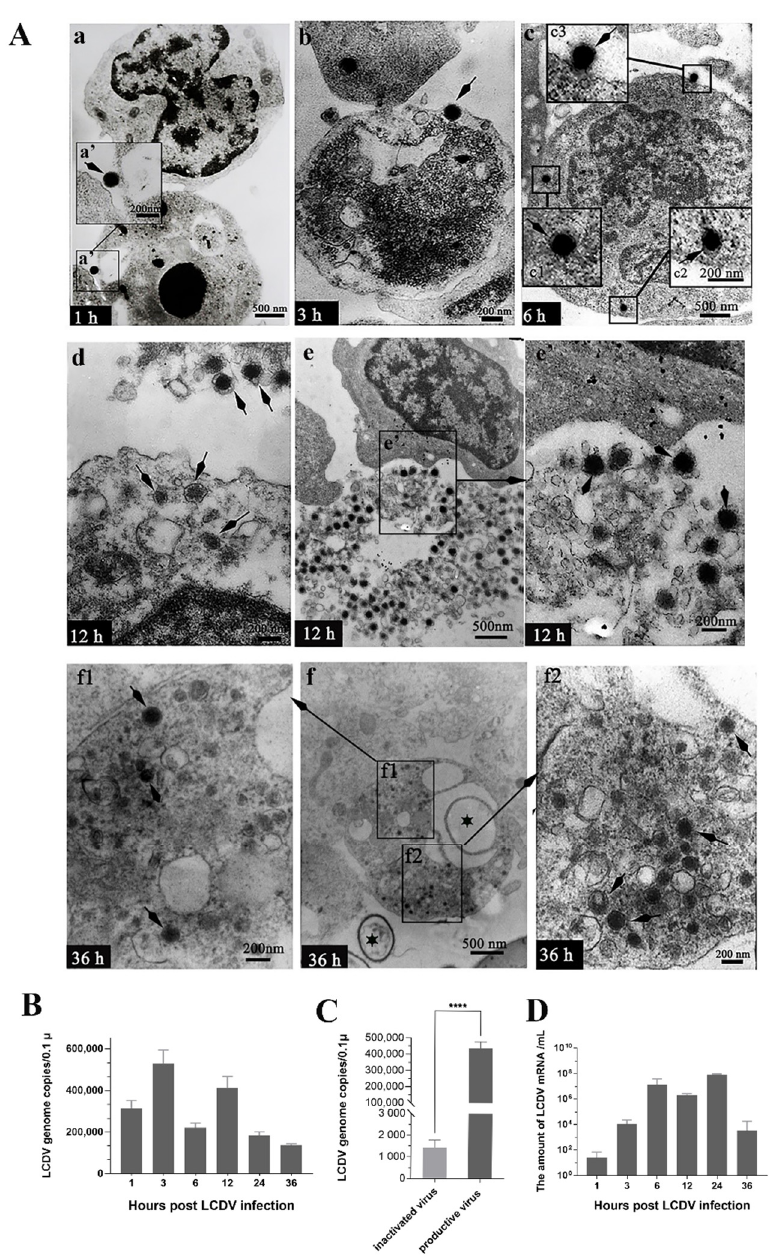
Figure 2. LCDV replication in flounder PBLs post in-vitro LCDV infection at different time points. ( A ) TEM micrographs of LCDV replication. The arrows showing LCDV particles in infected cells at 1 h, 3 h, 6 h, 12 h and 36 h post infection in vitro, respectively ( a – f ). ( a’ ) Higher magnification view of insert area from ( a ); ( c1 – c3 ) Higher magnification view of insert area from ( c ), showing LCDV particles on the cell membrane and in the cytoplasm of PBLs; ( e’ ) Higher magnification view of insert area from ( e ); ( f1 , f2 ) Higher magnification view of insert area from ( f ); The star in ( f ) showing the apoptotic bodies; Scale bar = 200 nm. ( B ) The LCDV copy numbers in PBLs at different time points post in vitro LCDV infection. ( C ) The LCDV copy numbers in PBLs incubated with produc- tive LCDV and UV-inactivated LCDV were detected at 12 hpi. **** p < 0.0001, unpaired t test. ( D ) Viral genome transcription in PBLs at different time points post LCDV infection. Error bars repre- sent SD ( n = 3).